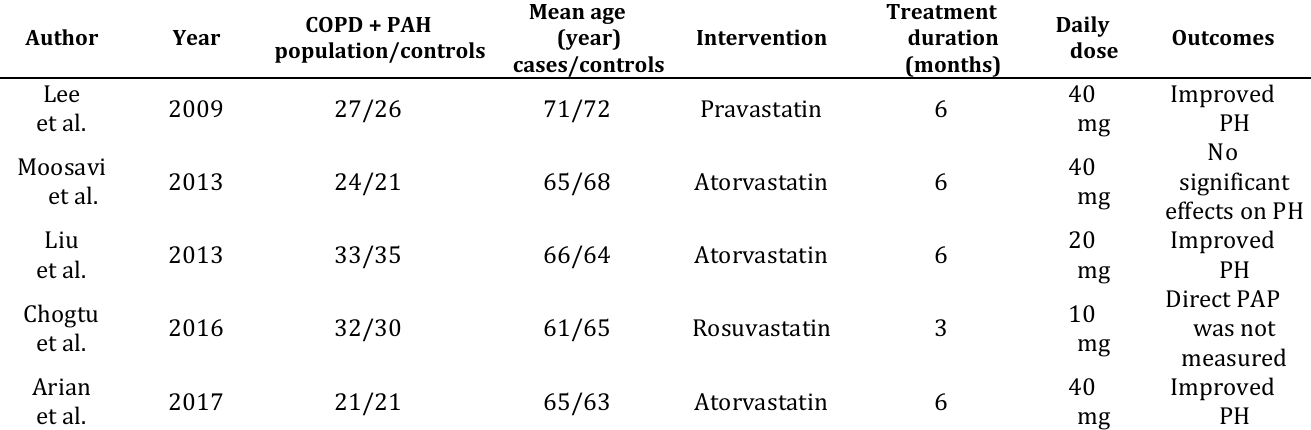
Table 1. Summary of clinical trials evaluating the effect of statins on COPD patients with pulmonary artery